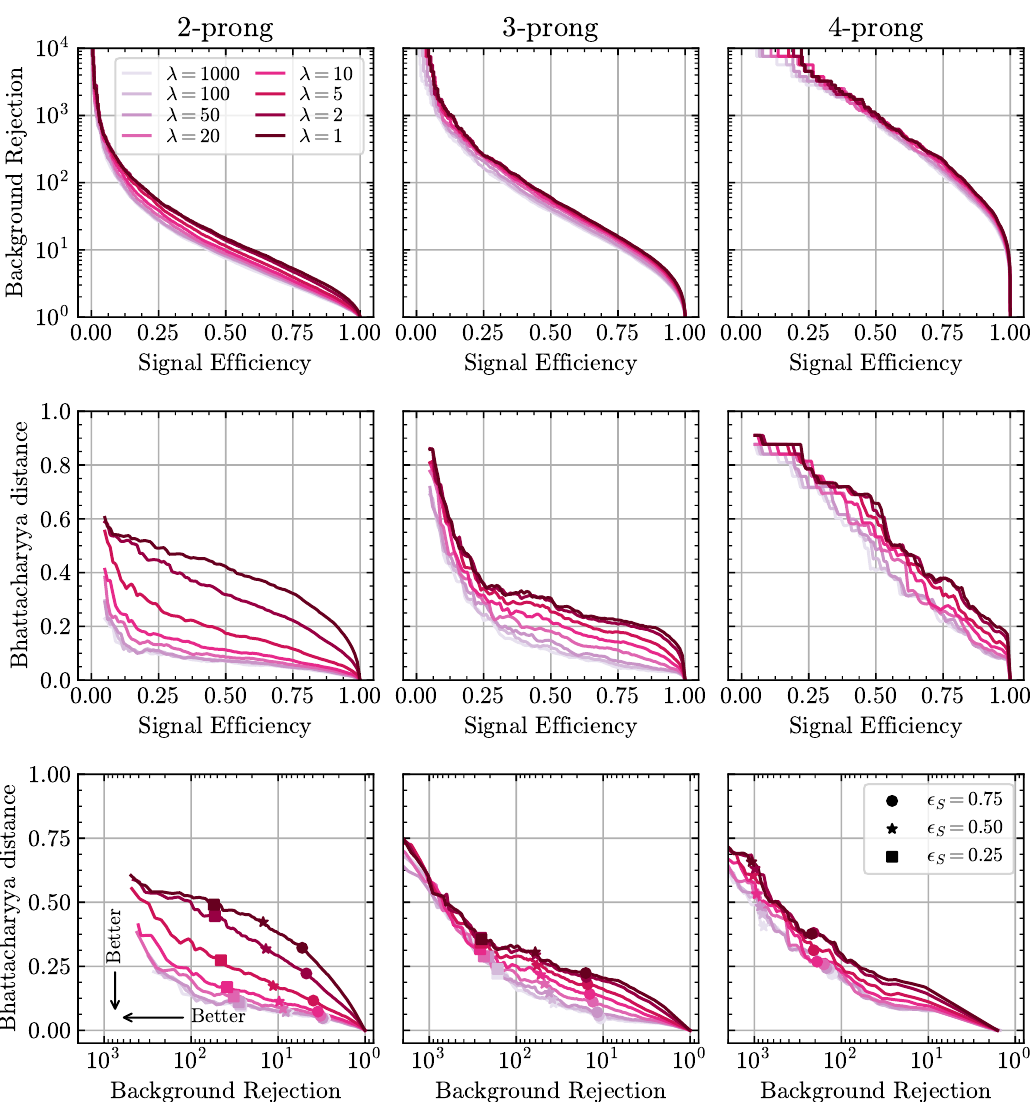
Figure 16: The top row shows the ROC curves for all of the adversarially-trained neural networks tasked with distinguishing the 2-, 3-, and 4-prong signal jets from the QCD background. Lighter shades correspond to increasingly larger values of λ . Larger values of λ put an increased emphasis on making the network output less dependent on the mass, at the cost of worse classification. The middle row shows how the Bhattacharyya distance for the QCD background changes as tighter cuts are made on the network output. As expected, higher values of λ lead to less sculpting than lower values of λ . The bottom row shows a parametric plot of the Bhattacharyya distance for the QCD background versus the background rejection. The adversarially- trained networks are all able to achieve similarly large background rejections, but networks using higher values of λ are able to reject much of the background while preserving the profile of the underlying distribution. All three rows show that the benefits of adversarial training saturate at λ =